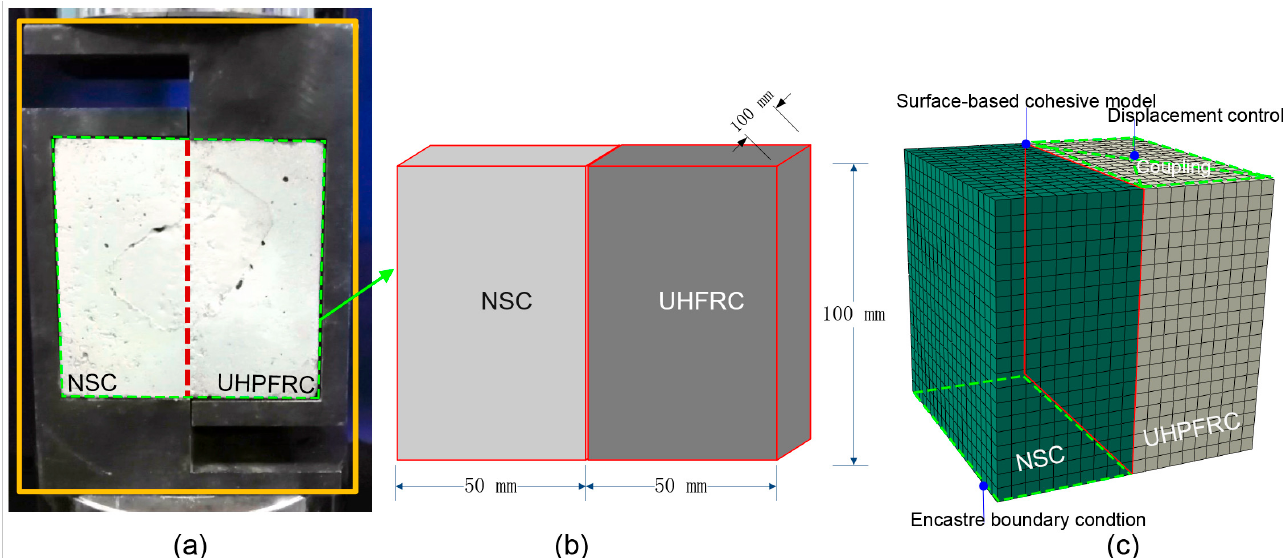
Figure 7. Pure shear test: ( a ) experimental setup [20]; ( b ) specimen dimensions; and ( c ) FE model.